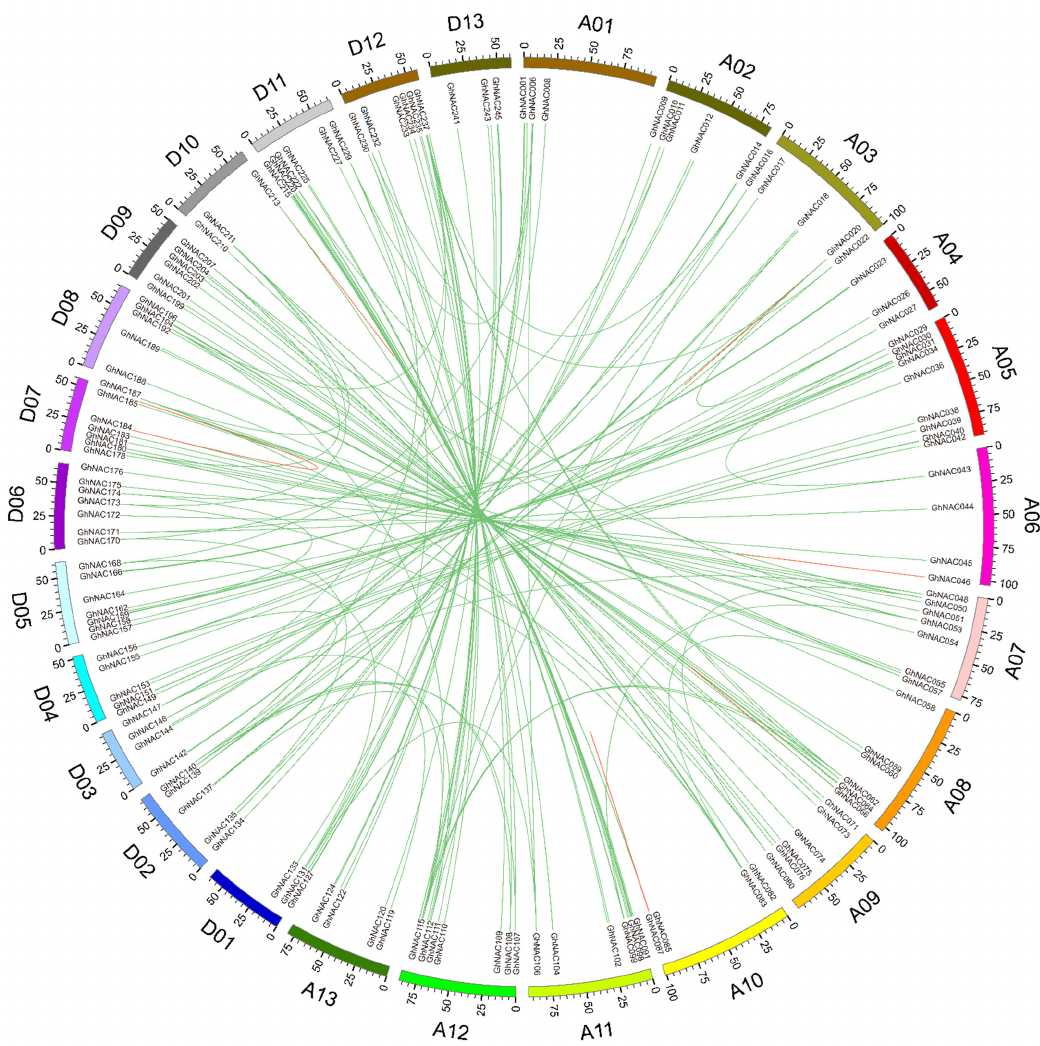
Figure 3. Circos diagram of the GhNAC duplication pairs in G. hirsutum L. The segmental duplication gene pairs were linked with green lines. The tandem duplicates are denoted by red lines. Scale bar marked on the chromosome indicating chromosome lengths (Mb).